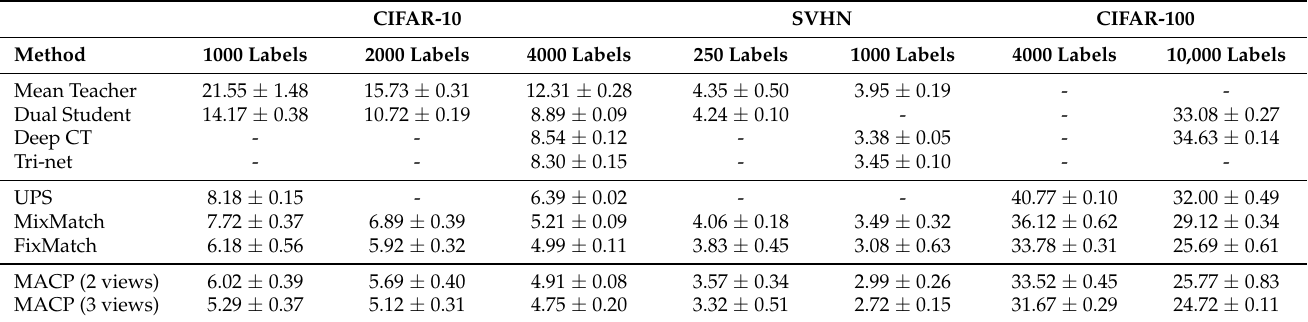
Table 2. Comparison of error rate (%) for CIFAR-10/100 and SVHN on three different labeled data folds, the comparison methods are tested under the same codebase. CIFAR-10 SVHN